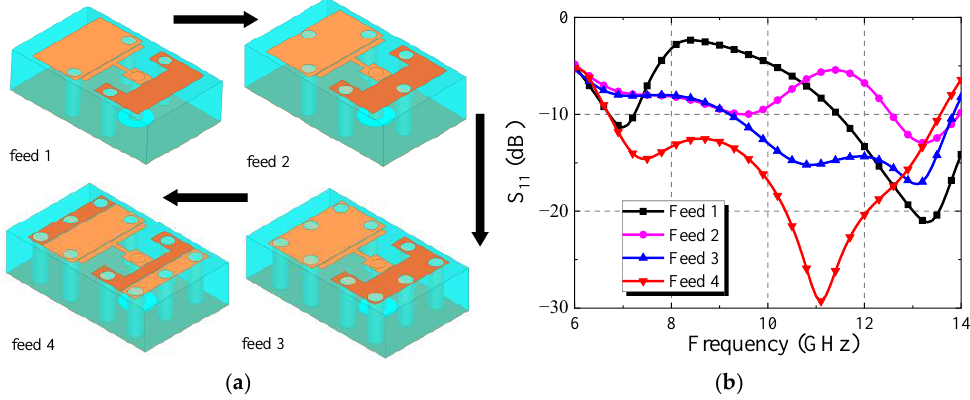
Figure 11. Simulation results of feed antenna ( a ) Design process of feed; ( b ) S 11 curve.